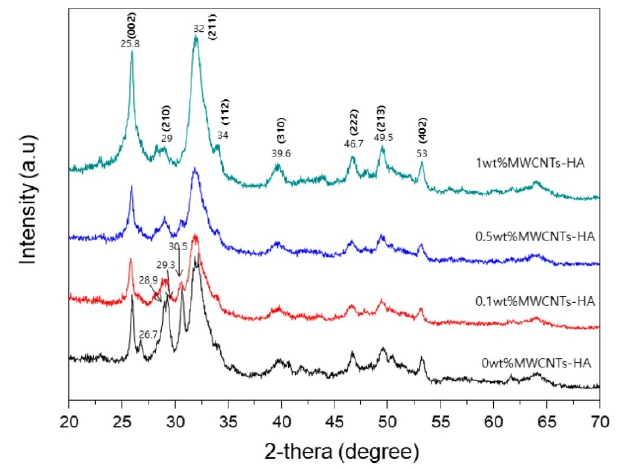
Figure 7. XRD patterns of HAp-MWCNTs composites [89].